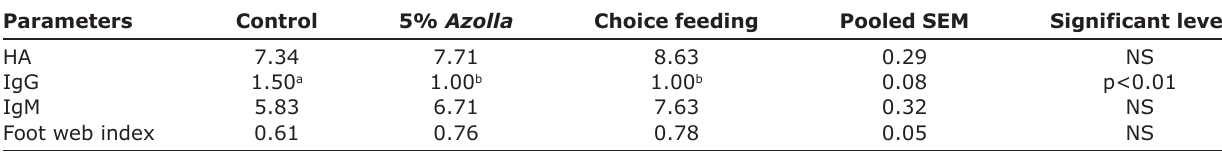
Table-5: Effect of Azolla feeding on the humoral immune responses (antibody titer [log 2] values) to 1% SRBC of values and cell-mediated immune response (response to PHA-P) (foot web index) of grower turkey at 16 weeks of age.